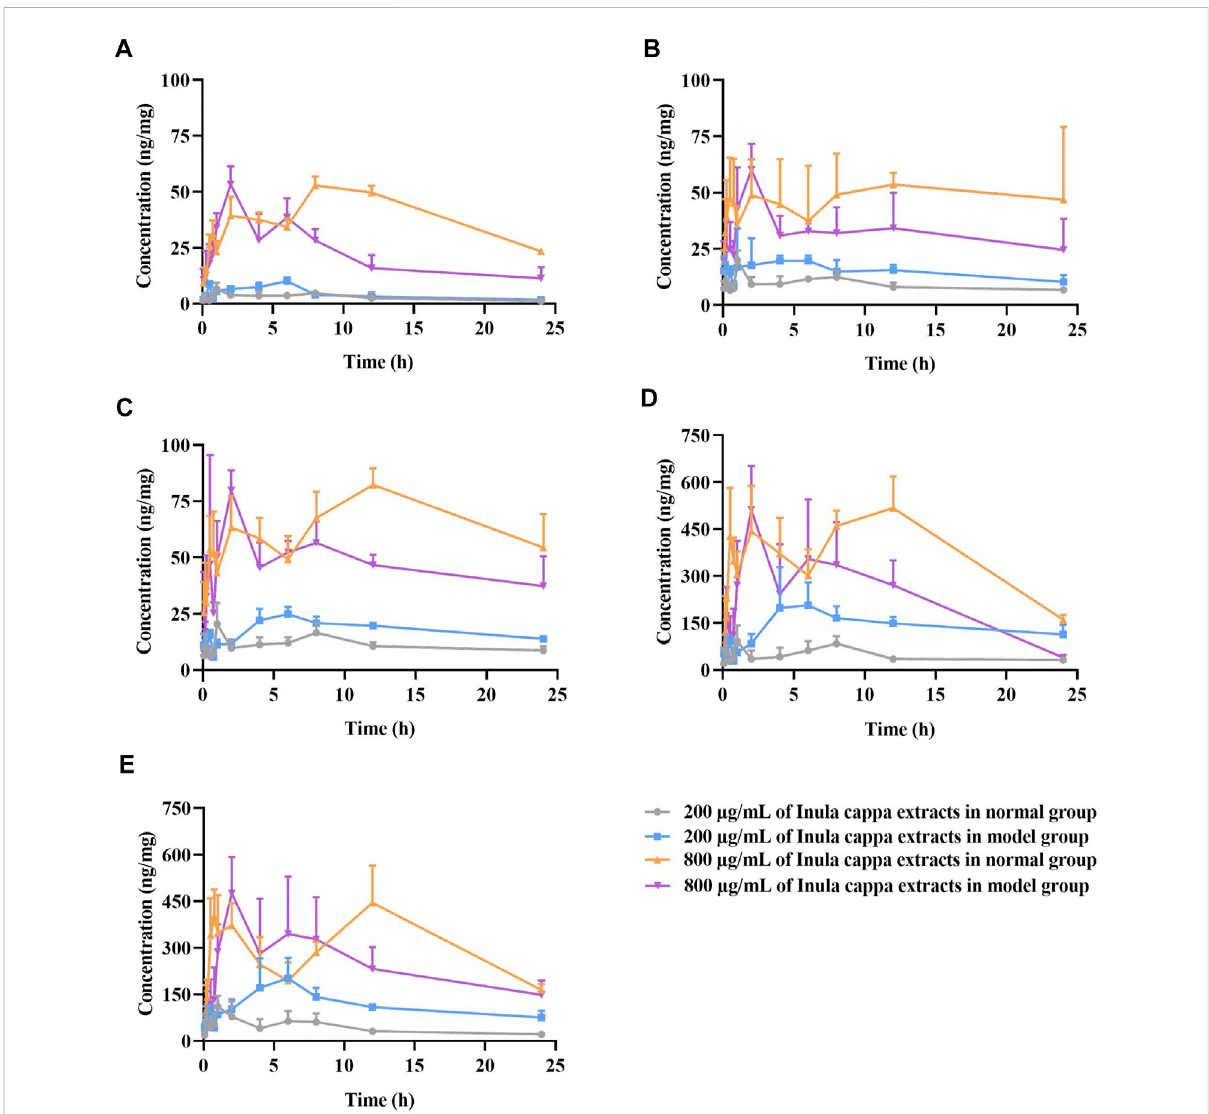
FIGURE 4 The mean concentration (ng/mg) of luteolin (A) , chlorogenic acid (B) , cryptochlorogenic acid (C) , 3,4-dicaffeoylquinic acid (D) , and 4,5- dicaffeoylquinic acid (E) versus time pro fi les in RAW264.7 cells after treatment with 200 μ g/ml and 800 μ g/ml of I. cappa extracts ( (cid:1) x ± SD, n = 6).